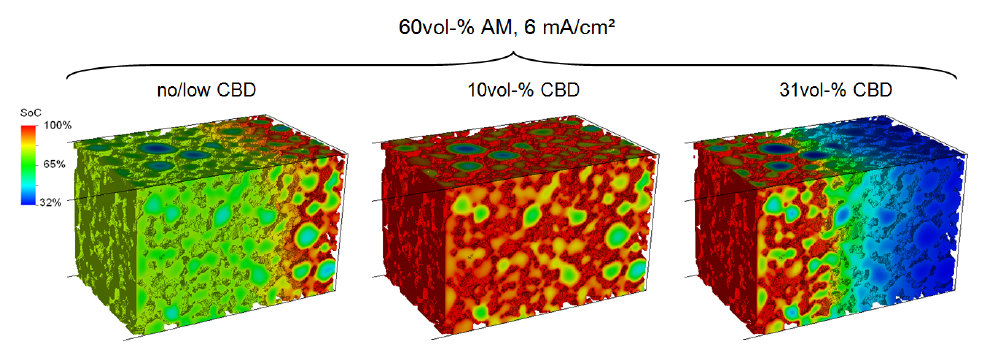
Figure 7. Normalized lithium concentration (SoC) in the CAM at the end of lithiation simulations with 6 mA/cm 2 . Left: No CBD. Middle: 10 vol-% CBD. Right: 30 vol-%